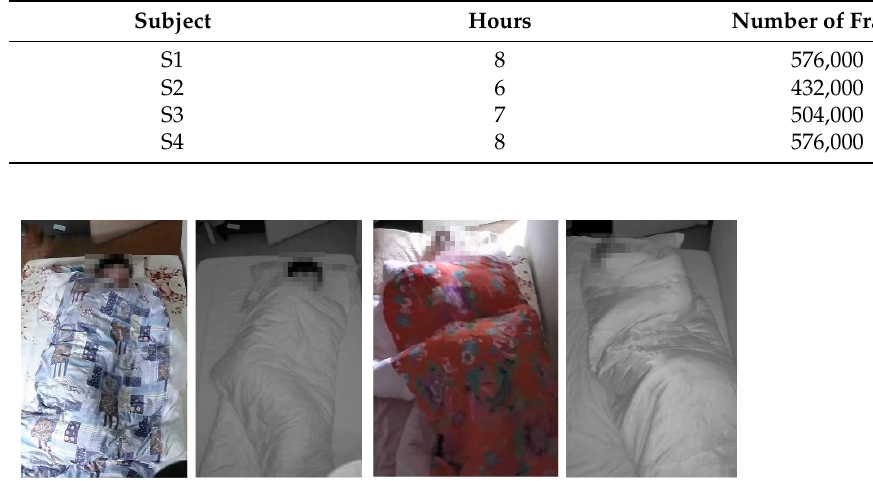
Figure 7. Examples of RGB/IR images from the iSP real-life dataset.